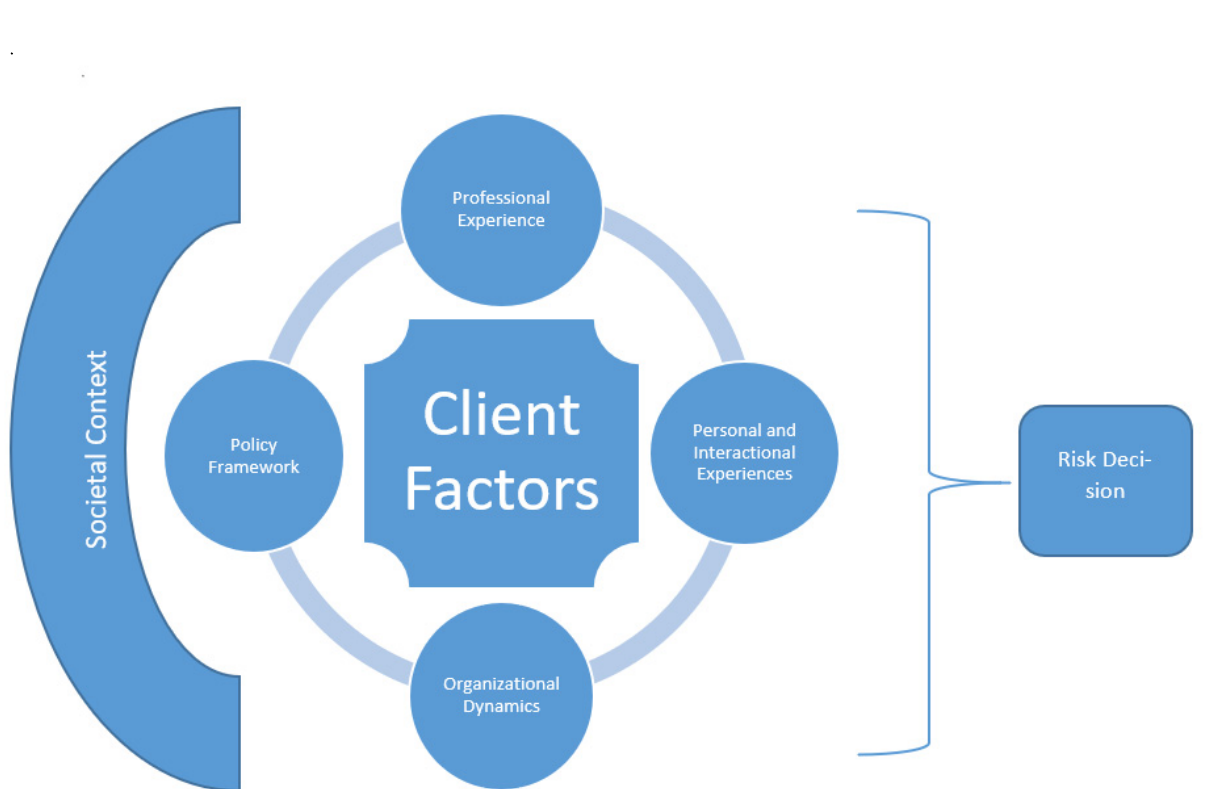
Figure 1. An Ecological Model for High-Risk Professional Decision-Making in Mental Health.